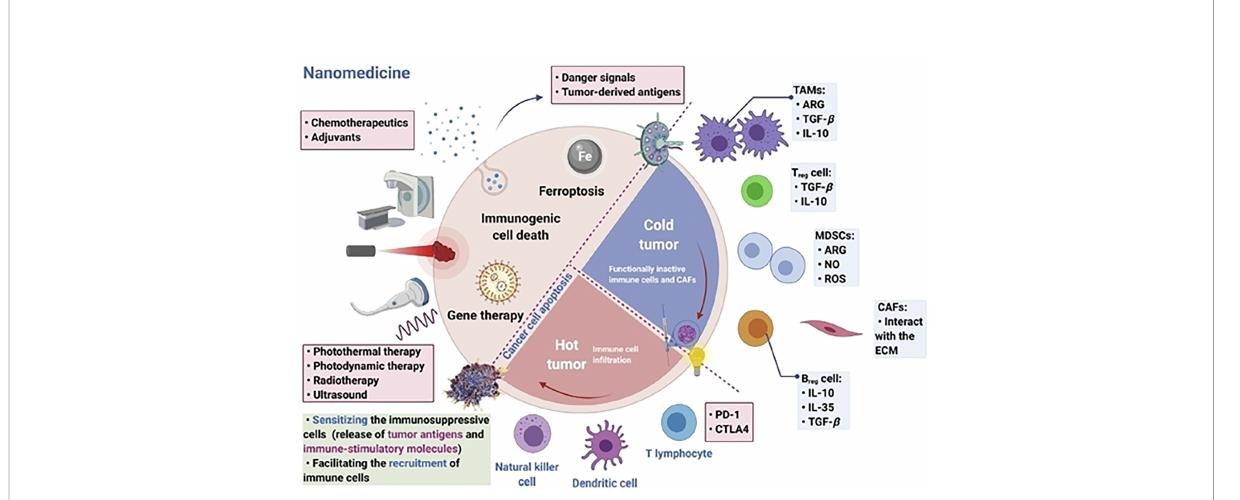
FIGURE 3 Targeting immunosuppressive cells inside the tumor microenvironment is vital for modern nanomedicine-based immunotherapy. Reproduced with permission from Ref (55). Copyright 2022,